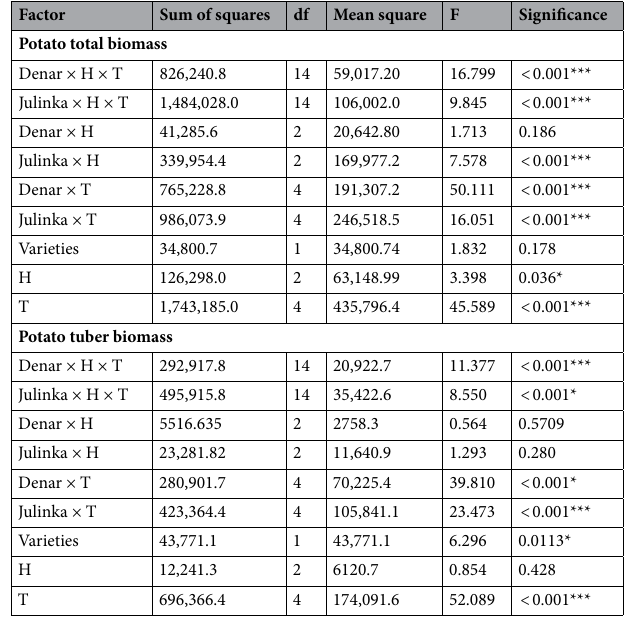
Table 3. Variance analysis for total biomass and tuber of potato depending on factors (significance verified by the Fisher test). d.f. degree freedom, F Fisher-Snedecor distribution, Denar potato varieties, Julinka potato varieties, H humidity level (1. 2, 3), T potato harvest term (I, II, III, IV, V). *,**,***Significance at p < 0.05, p < 0.01 and p <